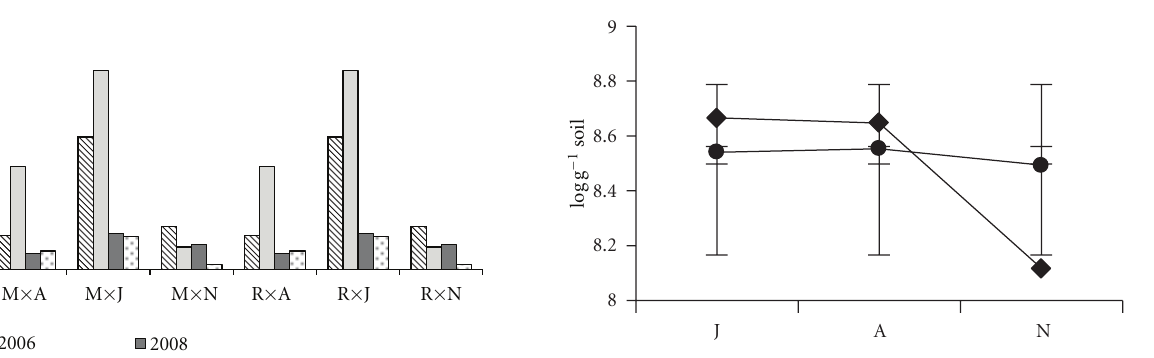
Figure 5: Heterotrophic counts on a logarithmic scale displaying di ff erent reactions to monoculture and rotation in the di ff erent seasons in 2007. Monoculture = M - (cid:2) -; rotation = R - • -. Vertical bars denote standard